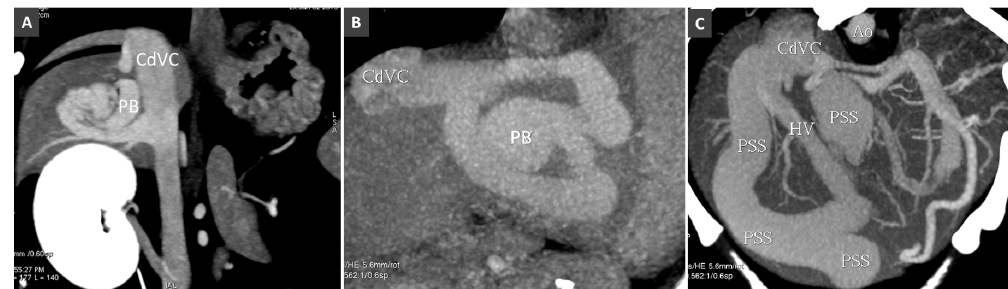
Figure 12. A . Intrahepatic PSS in a dog involving a single hepatic lobe. PB, portal branch; CdVC, caudal vena cava. B . Intrahepatic PSS through an aneurysmal dilatation of a portal branch (PB). C . Multiple intrahepatic portosystemic connections involving several hepatic lobes.